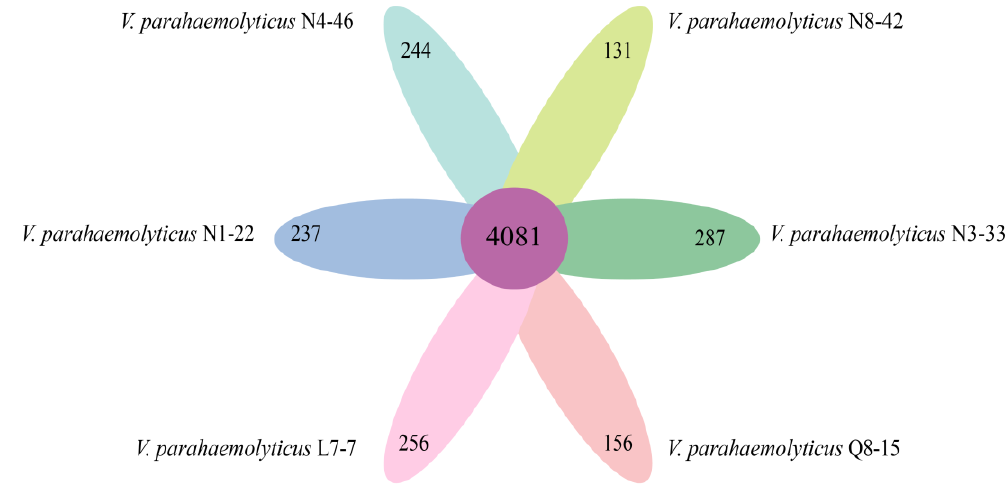
Figure 9. Venn diagram showing the core genes and strain-specific genes in the six V. parahaemolyt- Figure 9. Venndiagramshowingthecoregenesandstrain-specificgenesinthesix V.parahaemolyticus icus genomes.